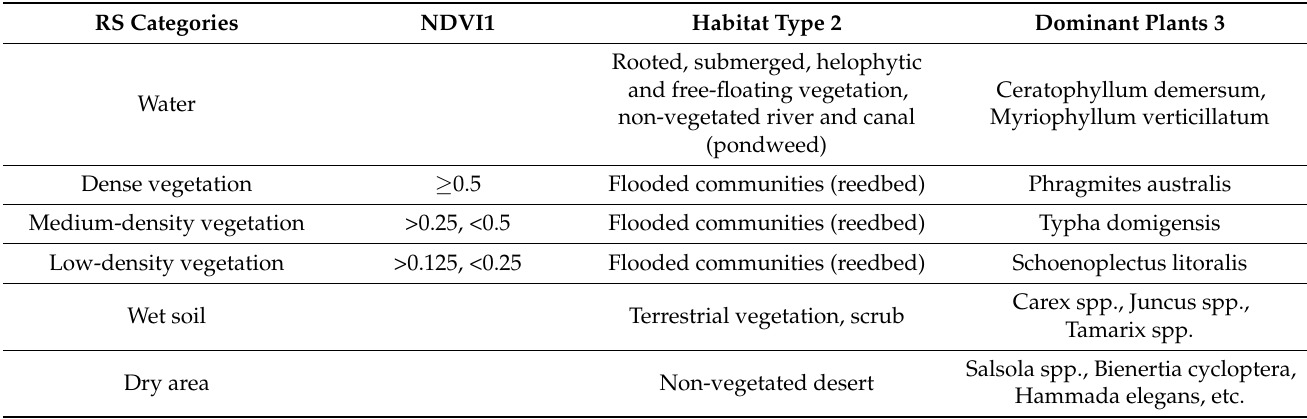
Table 2. Comparison of land cover categories based on remote sensing in this study and the habitat types of the Al Hammar marsh [32,38,44].